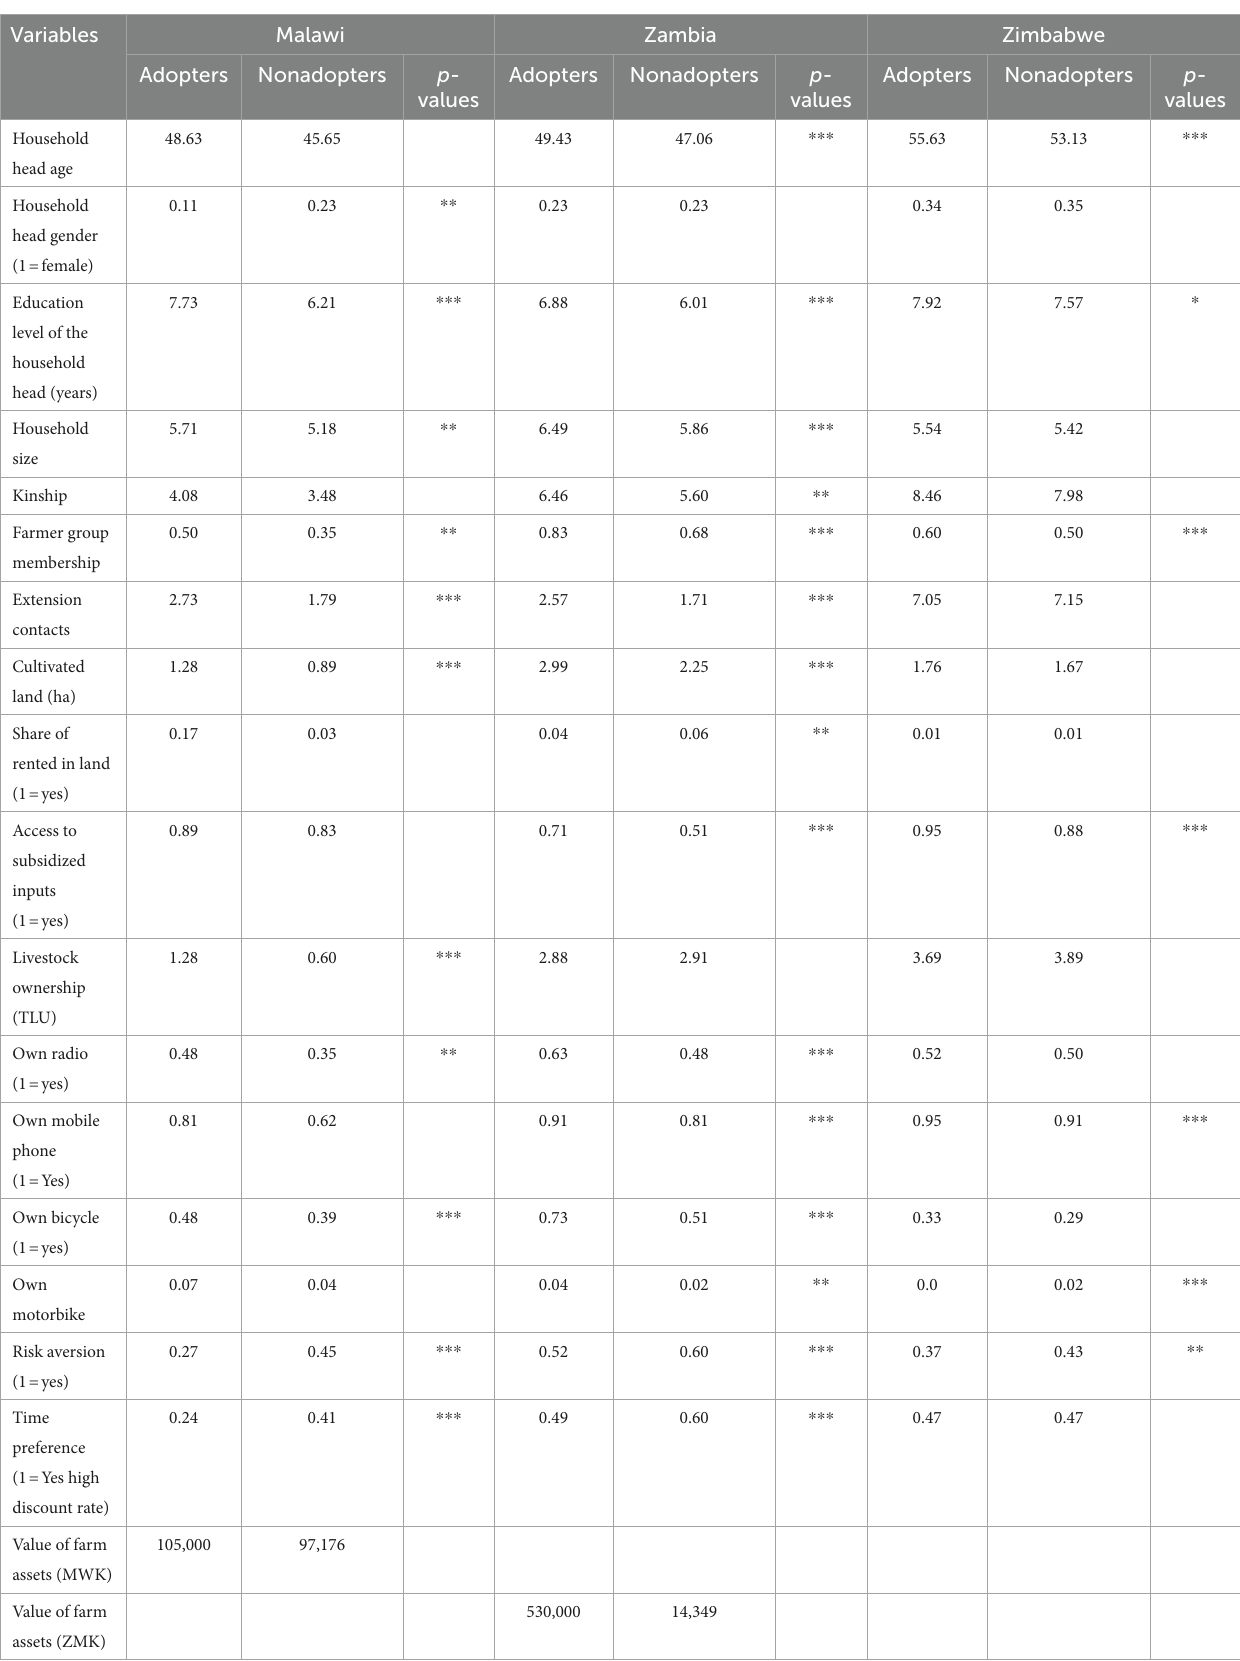
TABLE 6 Household characteristics by minimum tillage-based adopters and non-adopters (mean). Variables